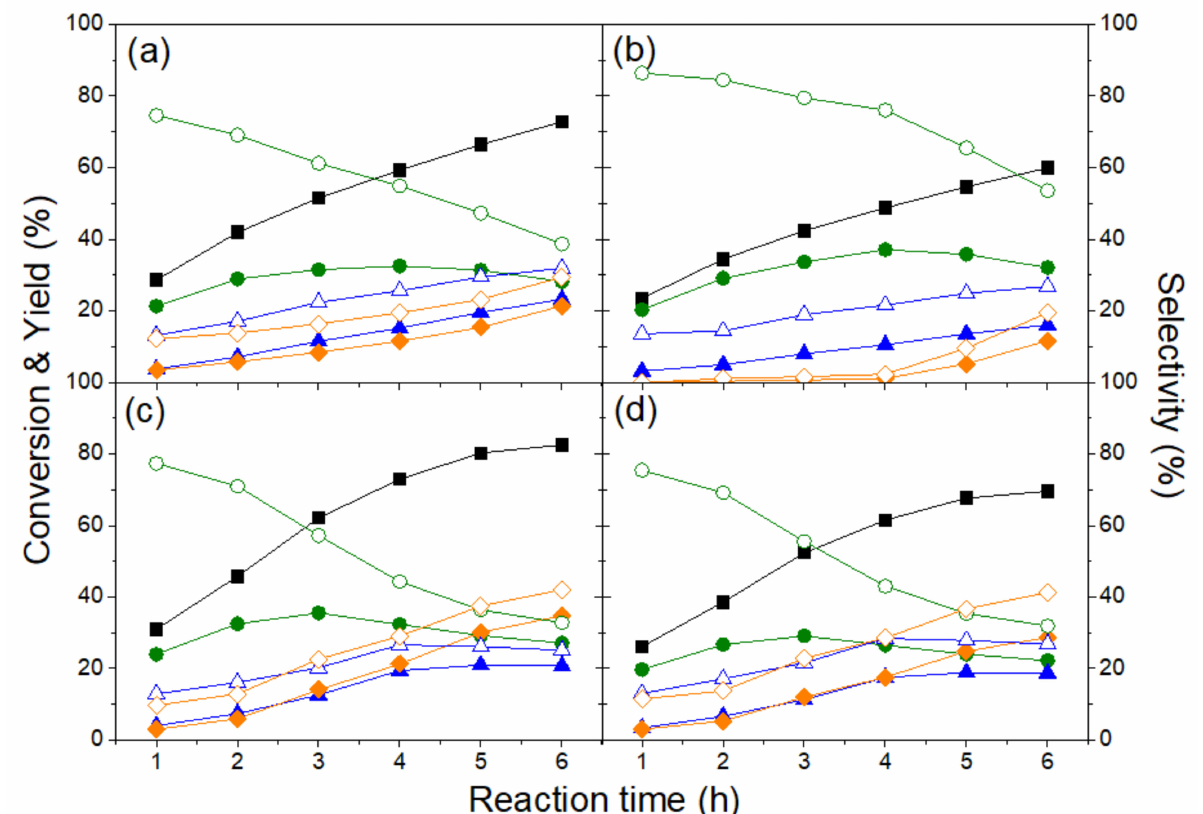
Figure 1. Influence of the reaction time on the etherification of glycerol in the presence of ( a ) NaOAc, ( b ) NaOAc + hexanoic acid, ( c ) KOAc, and ( d ) KOAc + hexanoic acid (- (cid:4) -: conversion of glycerol, - • -: yield of DG, - (cid:78) -: yield of TG, - (cid:7) -: yield of others - -: selectivity of DG, - ∆ -: selectivity of TG, - ♦ -: selectivity of others, the amount of catalyst: 0.5 mol%, the amount of (cid:35) hexanoic acid: 3 mol% and reaction temperature: 260 ◦